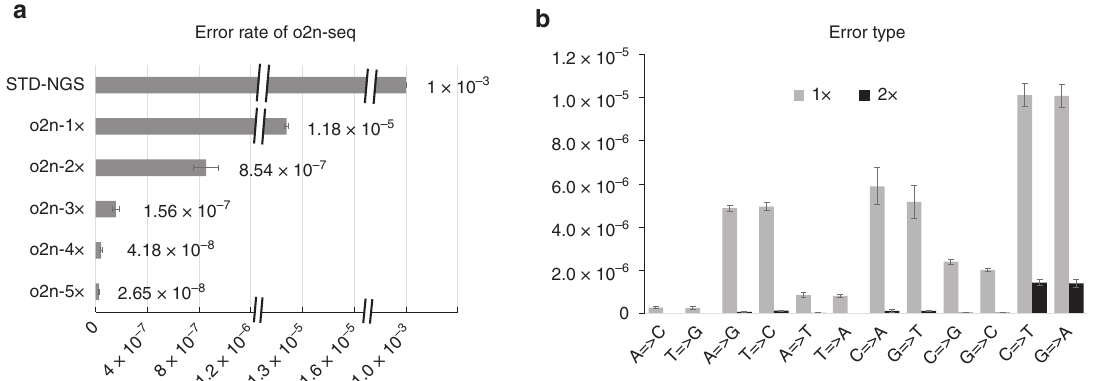
Figure 3 | Error rates and mutation types obtained by o2n-seq. ( a ) Error rates of o2n-seq under different CSs support conditions (three experimental replicates, means ± s.d.). STD-NGS, standard next-generation sequencing method. ( b ) Mutation types obtained by o2n-seq for 1 (cid:3) or 2 (cid:3) CSs (three experimental replicates, means ± s.d.). lower than that of STD-NGS when counting the 1 (cid:3) CSs. The gradually slows. This may be caused by ‘errors’ that were actually error rate decreased to 8.54 (cid:3) 10 (cid:2) 7 ( ± 9.44 (cid:3) 10 (cid:2) 8 ), bone fide ultralow-frequency mutations too far from fixation in 1.56 (cid:3) 10 (cid:2) 7 ( ± 2.67 (cid:3) 10 (cid:2) 8 ), 4.18 (cid:3) 10 (cid:2) 8 ( ± 7.03 (cid:3) 10 (cid:2) 9 ) and the W3110 cell population. 2.65 (cid:3) 10 (cid:2) 8 ( ± 1.76 (cid:3) 10 (cid:2) 9 ) when counting the 2 (cid:3) CSs, 3 (cid:3) Furthermore, we profiled the pattern of errors for o2n-seq. The CSs, 4 (cid:3) CSs and 5 (cid:3) CSs, respectively (Fig. 3a). The error rate error spectrum obtained when counting the 1 (cid:3) CSs indicated for 2 (cid:3) CSs was 13.82 times lower than that for 1 (cid:3) CSs. The that the error rates of two types of transitions (C ¼ 4 T and error rate for 3 (cid:3) CSs was 5.47 times lower than that for 2 (cid:3) CSs. G ¼ 4 A) were highest and two other types of transitions The error rate for 4 (cid:3) CSs was 3.73 times lower than that for 3 (cid:3) (A ¼ 4 G and T ¼ 4 C) and transversions (C ¼ 4 A and CSs. The error rate for 5 (cid:3) CSs was B 1.58 times lower than that G ¼ 4 T) exhibited higher error rates than other types of errors for 4 (cid:3) CSs. These results indicated that the error rate decreases (Fig. 3b). As expected, the rates for all types of errors decreased as a site is supported by more CSs. However, the rate of decrease significantly when counting 2 (cid:3) CSs, whereas the error rates of NATURE COMMUNICATIONS|8:15335|DOI: